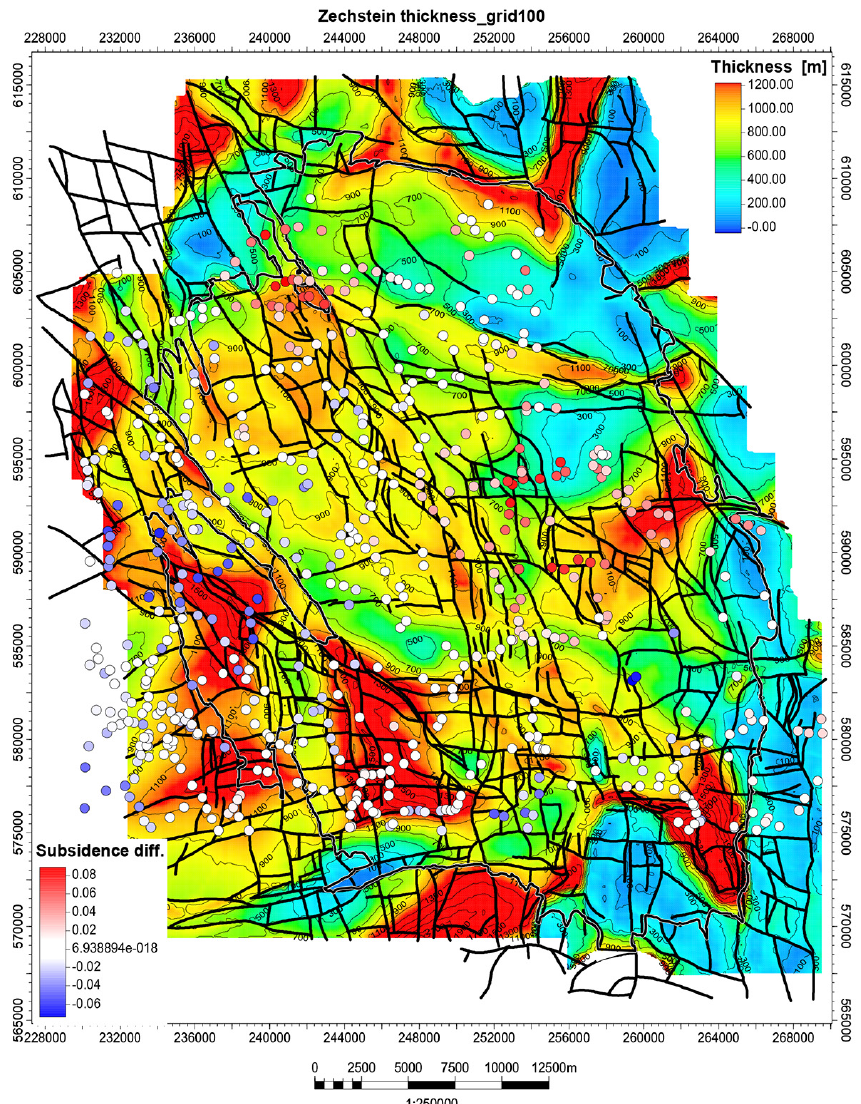
Figure 2. Thickness (m) of the Zechstein salt layer. The difference between calculated and modeled subsidence (m) is indicated at the benchmark locations (label: subsidence diff). A red color indicates that the measured subsidence is larger than the modeled subsidence (from: TNO,